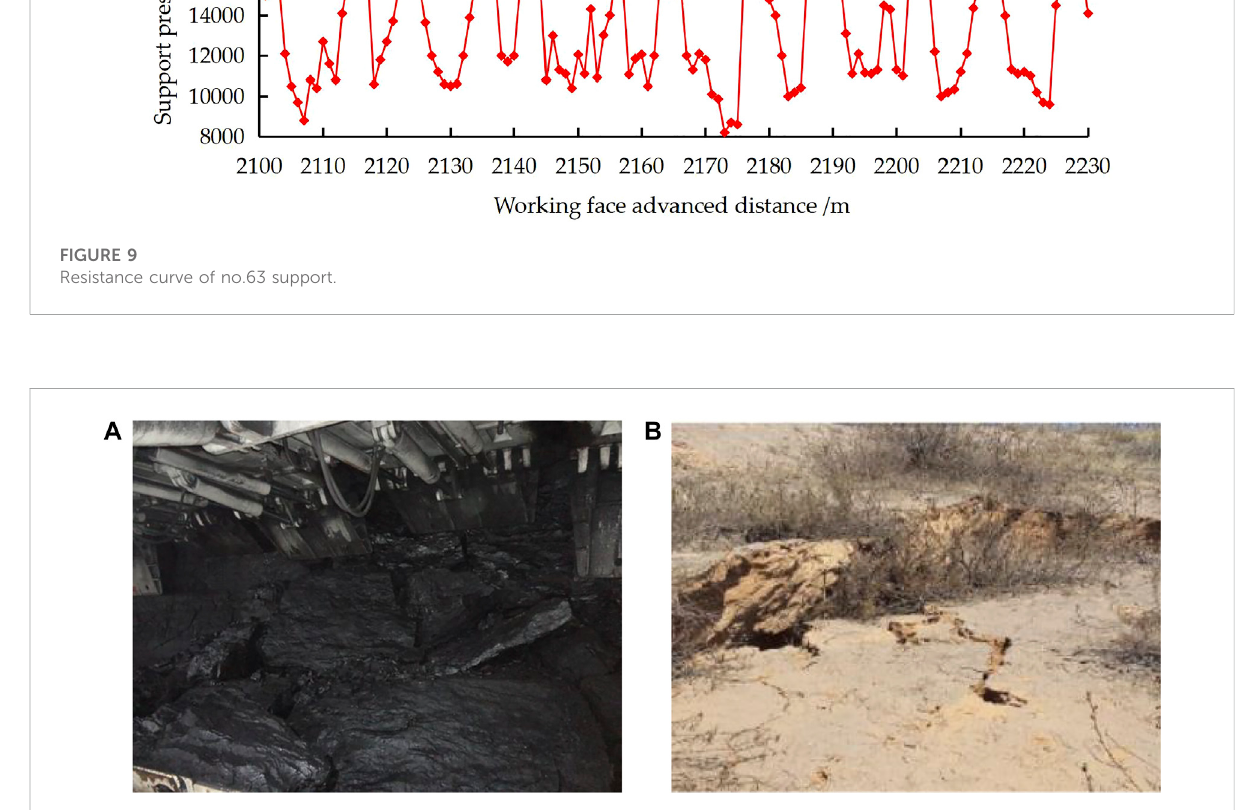
FIGURE 10 Roof disasters of no. 22,310 fully mechanized mining face: (A) rib fall of the coal wall, (B) step sinking of the